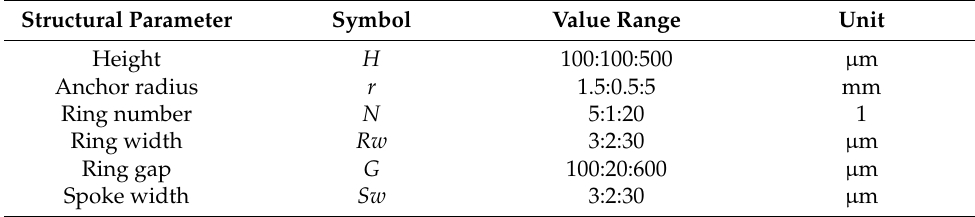
Table 1. The structural parameter range table of the disk MEMS resonator.